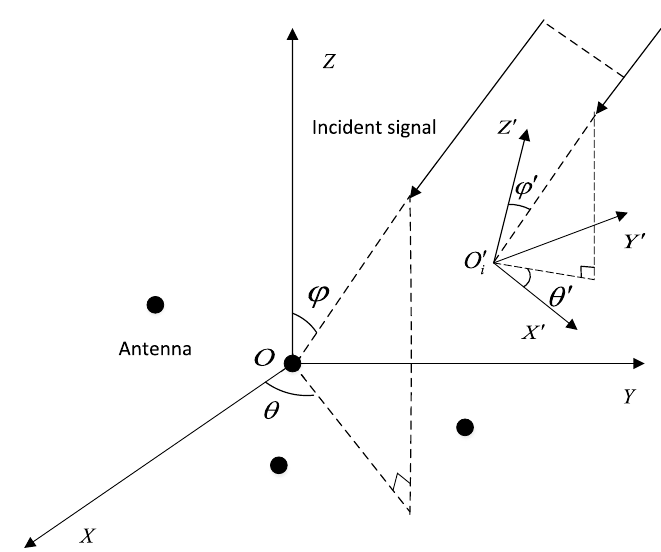
Fig. 1 Arbitrary conformal polarization sensitive